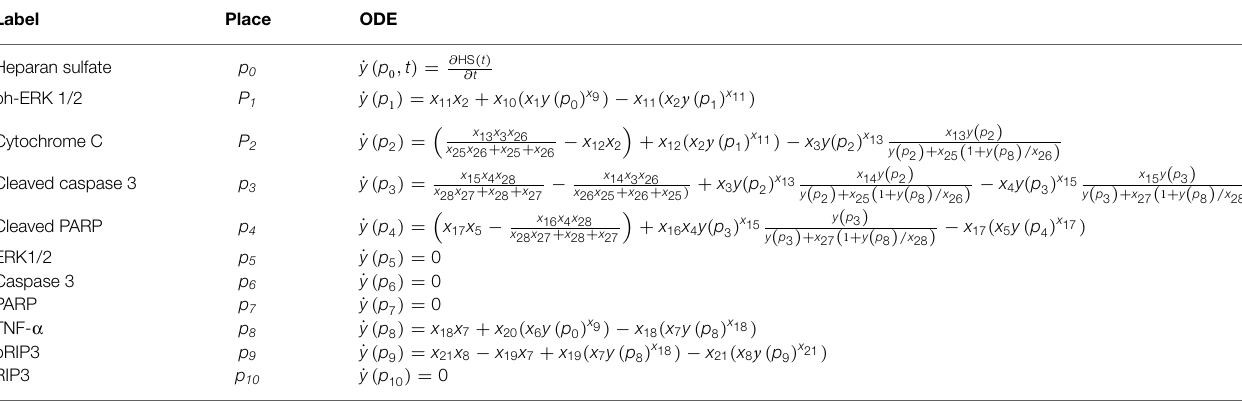
TABLE 1 | Ordinary differential equations (ODEs) of the proposed Petri net model. Label Place ODE